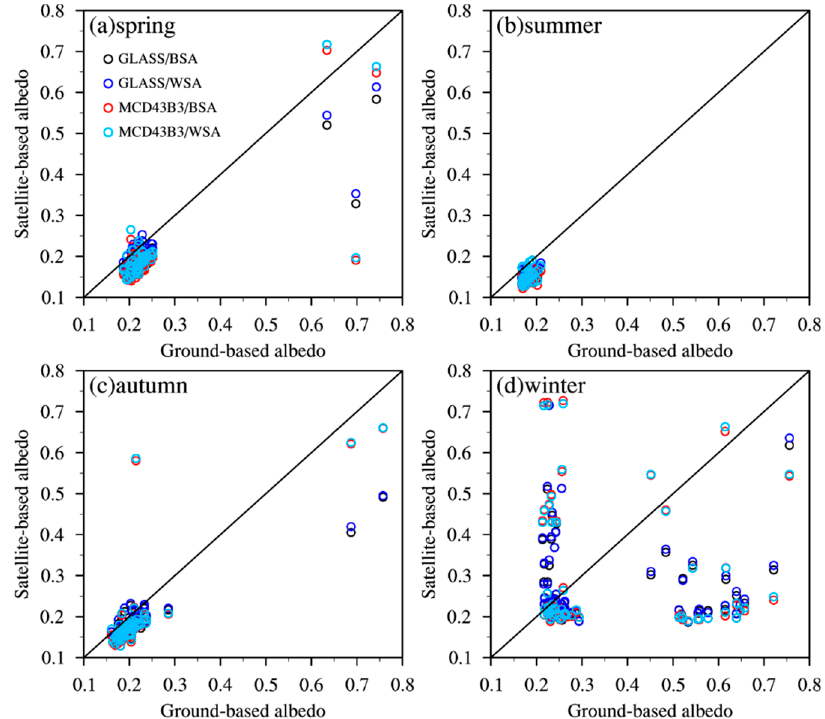
Figure 6. Scatter plots of seasonal changes in albedo for GLASS, MCD43B3, and ground-based at Maduo site over the years during ( a ) spring, ( b ) summer, ( c ) autumn, and ( d ) winter.